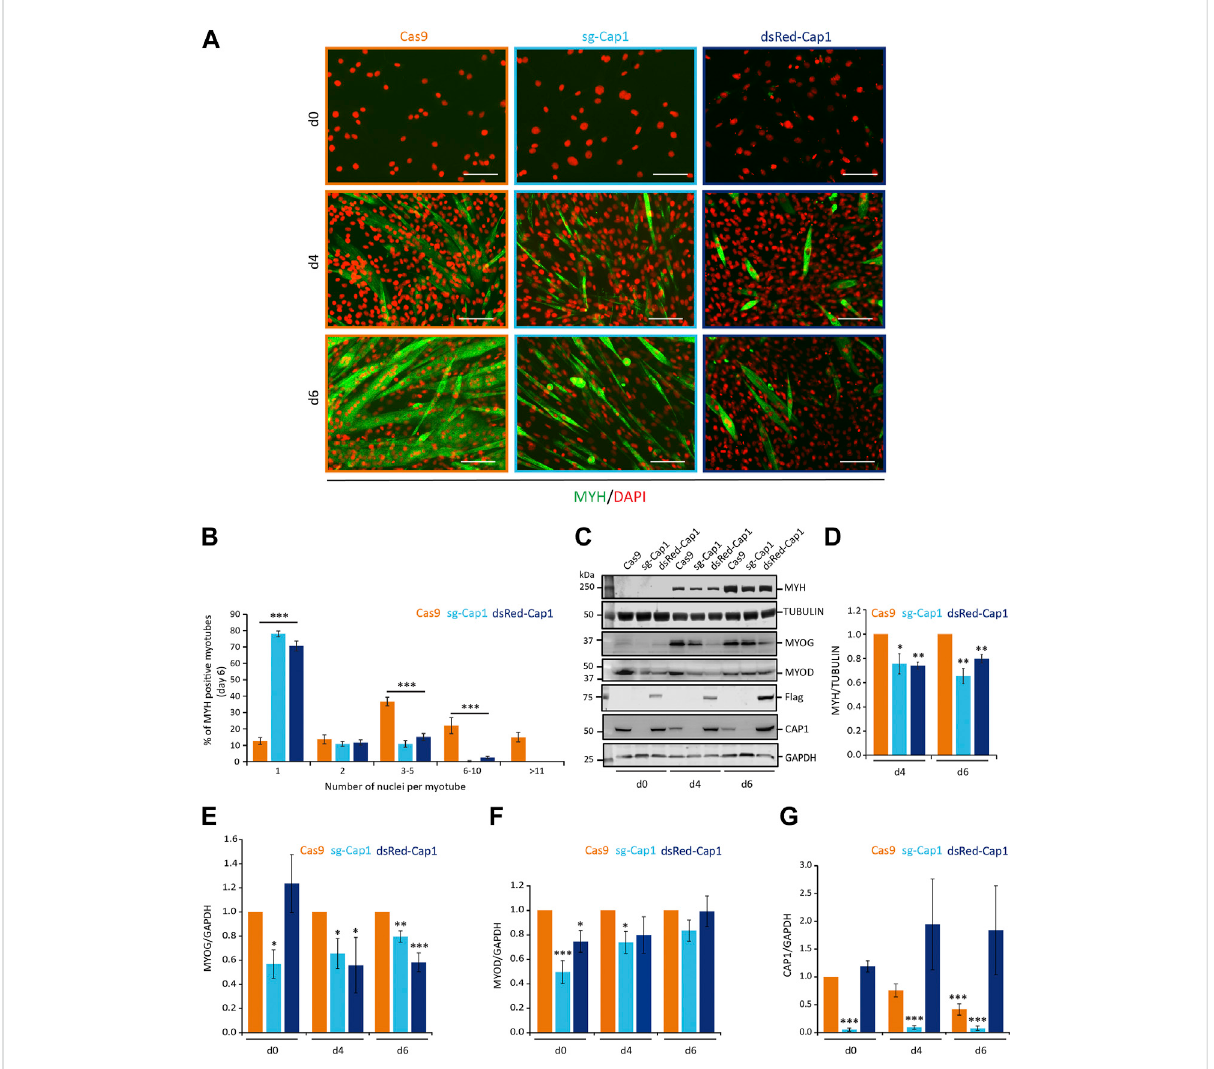
FIGURE 3 Timely downregulation of CAP1 is important for myoblast fusion. (A) Cas9 control cells, knockout (sg-Cap1) and overexpressing (dsRed-Cap1) cells atday 0(d0), day 4 (d4)and day 6(d6) of their differentiation. Pools of C2C12 cells werestained for MYH (green) and nucleus (DAPI, orange). (B) Quanti fi cation of the percentage of myotubes containing the indicated number of nuclei per myotube in control, knockout and overexpressing myotubesafter6 daysofdifferentiation(minimum200MYHpositivemyotubeswerecounted). (C) WesternblotforthemyogenicmarkerMYH, TUBULIN, MYOG, MYOD, Flag, CAP1, and GAPDH at day 0 (d0), days 4 (d4) and 6 (d6) of the differentiation. (D – G) Quanti fi cation of MYH, MYOG, MYOD,andCAP1immunoblotsatmyogenicdifferentiationfor4and6 days,normalizedtoCas9controlcells. Errorbars ,SEM( n =3);* p < 0.05,** p